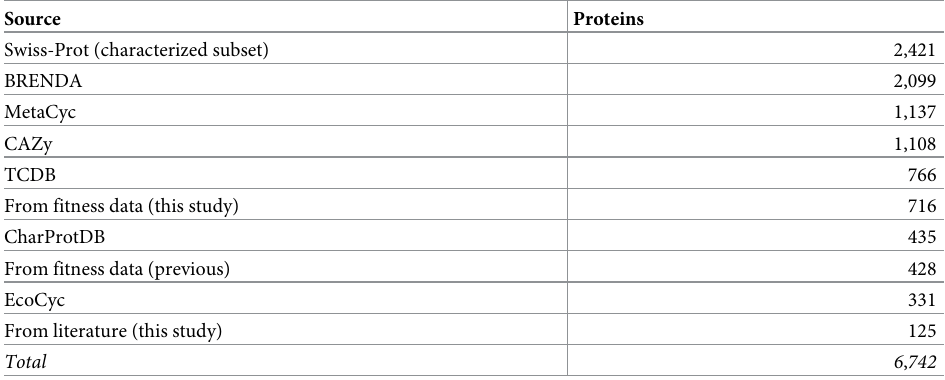
Table 1. The sources of the experimentally-characterized proteins that perform the steps in GapMind. The total is less than the sum of the entries because many proteins appear in more than one